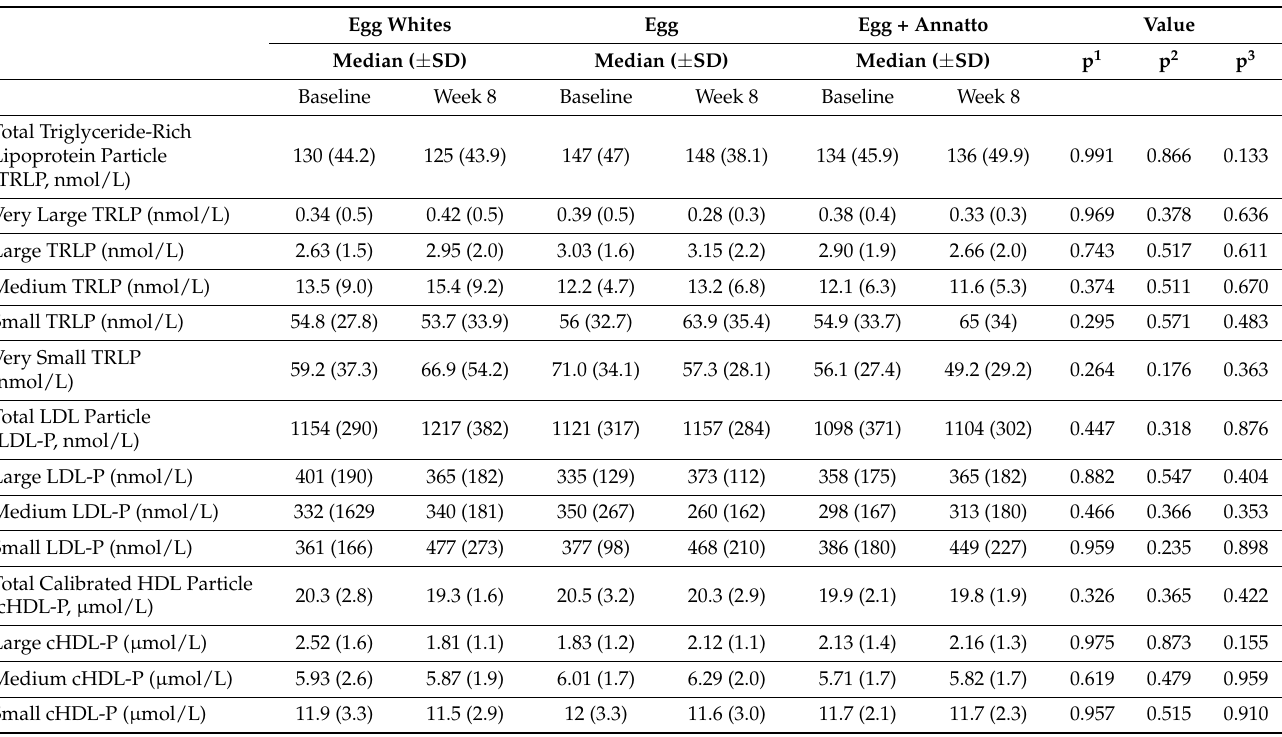
Table 4. Effects on lipoprotein subclasses’ concentrations and by size in the studied population according to